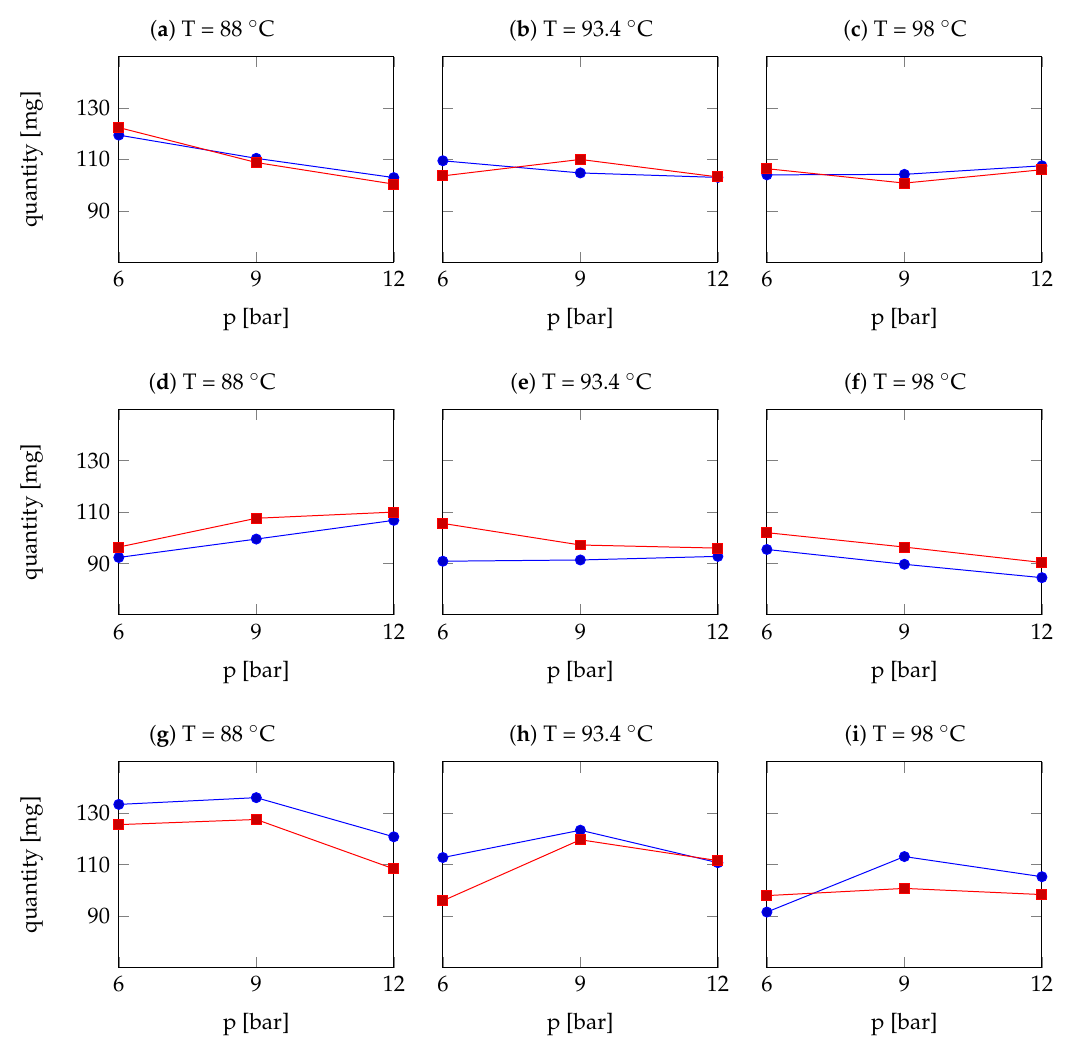
Figure 16. Comparison between the tartaric acid extracted through numerical simulations (blue profile with circles) and laboratory measurements (red profile with squares), with different inlet water tempera- tures and pressures and different grain size of Robusta coffee powder. Figures ( a – c ) show the results of optimal granulometry, Figures ( d – f ) of coarse granulometry and Figures ( g – i ) of fine granulometry.